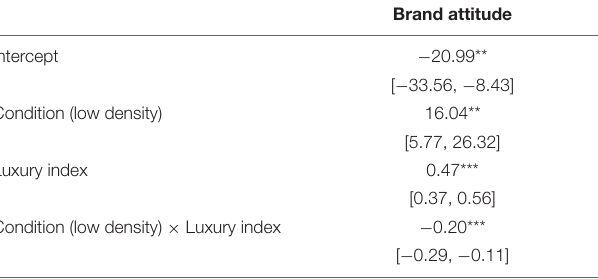
TABLE 1 | Results, unstandardized regression coefficients.